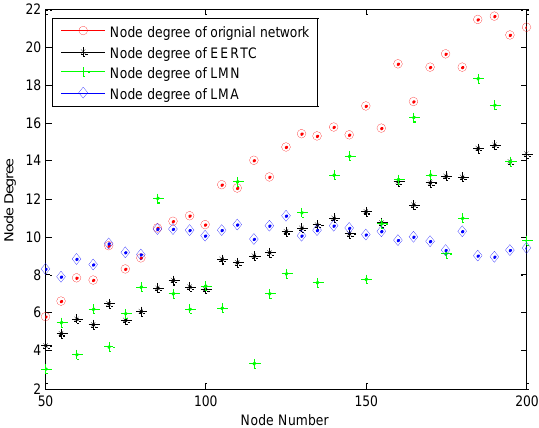
Figure 12. The relationship between node number and node degree in four protocols.